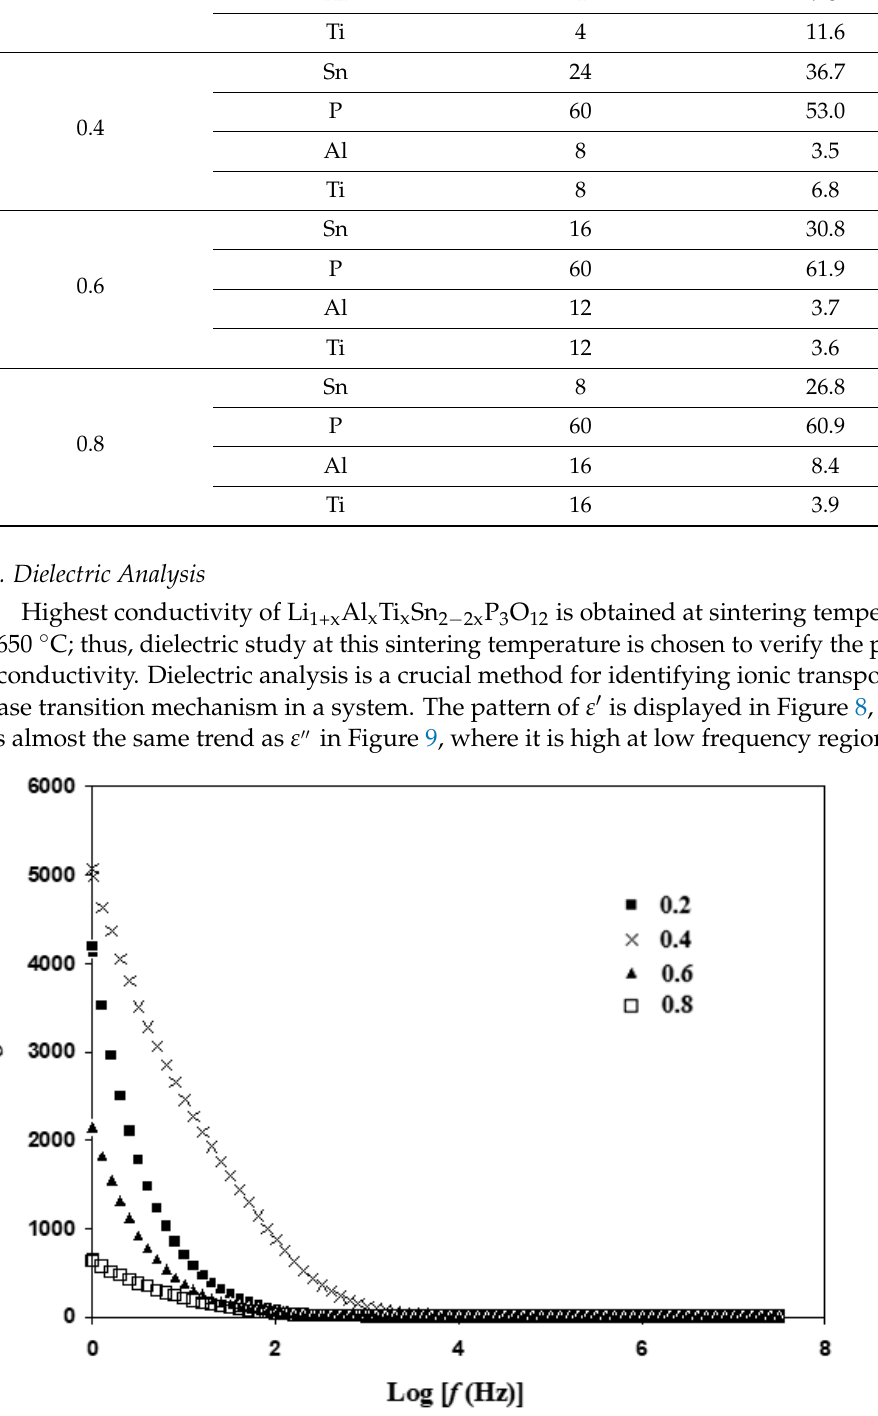
Figure 8. Variation of 𝜀 ’ at different frequencies for Li 1+x Al x Ti x Sn 2-2x (PO 4 ) 3 at sintering temperature of 650 °C.